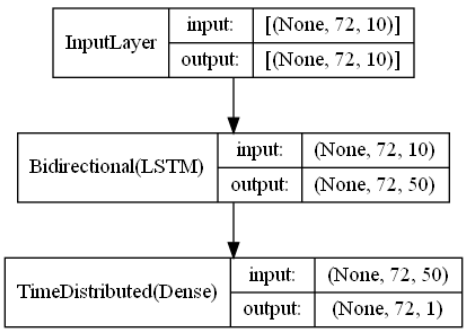
Figure 7. Functional unit that maps weather forecast to the